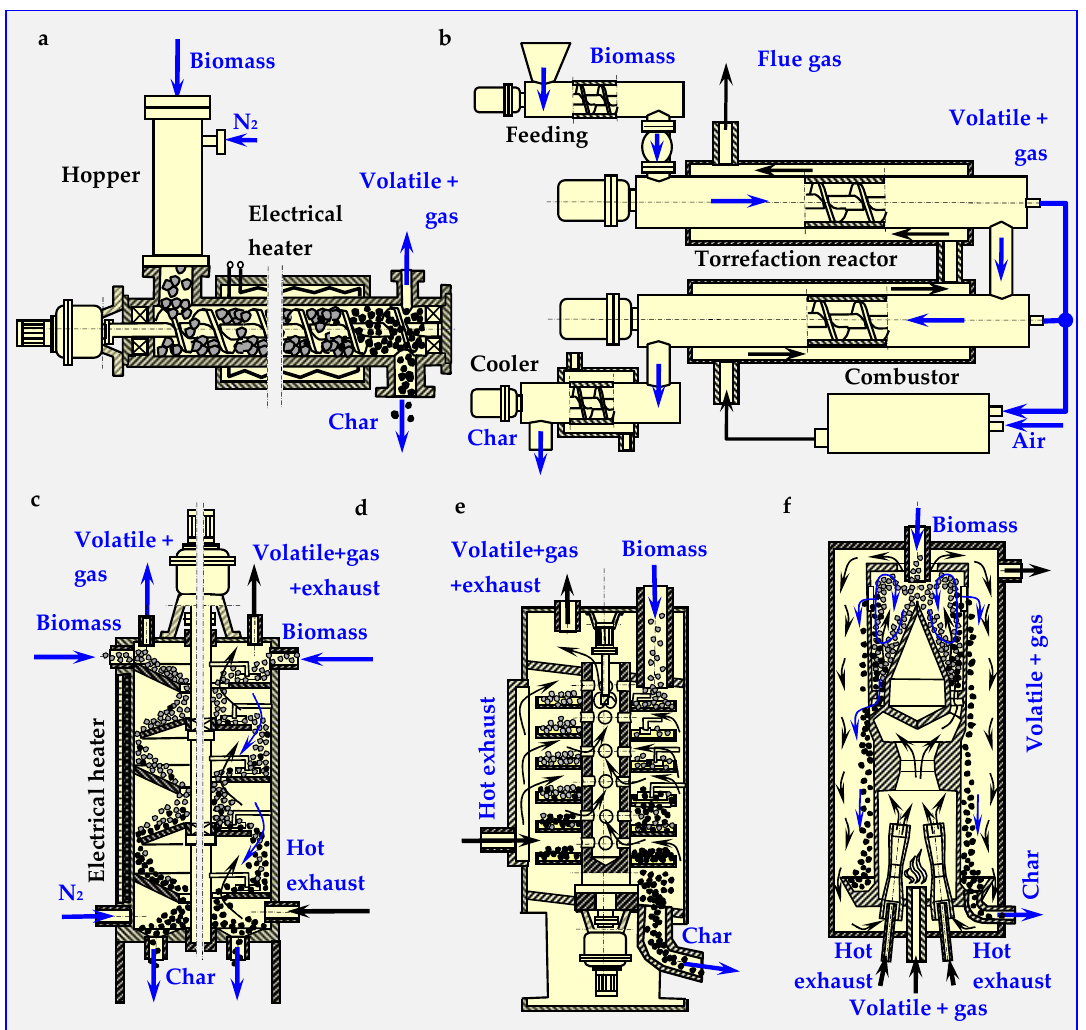
Figure 5. Diagrams of the most popular reactors and devices for continuous biomass torrefaction.